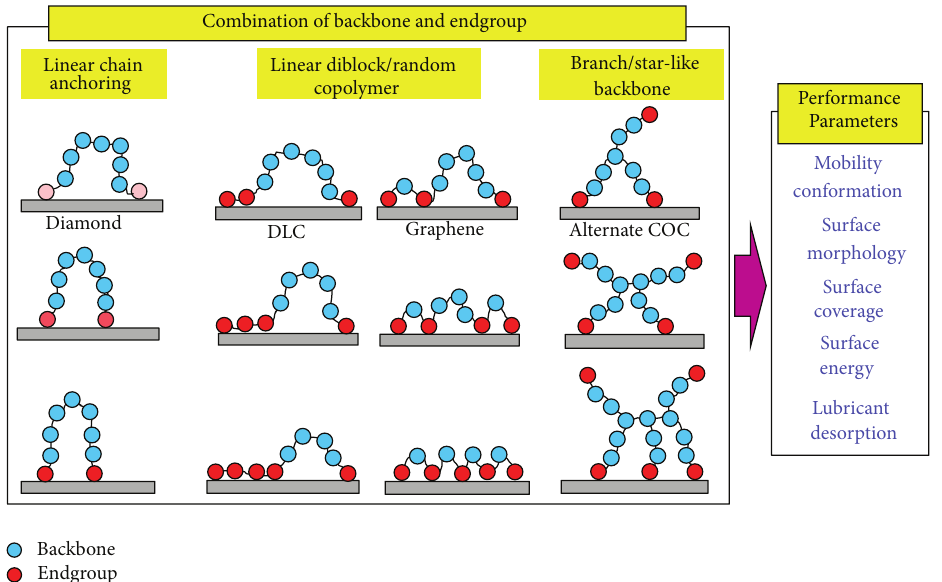
Figure 29: Different types of PFPEs with atomistically/molecularly architectured functional molecular structures on the various COC layers and output